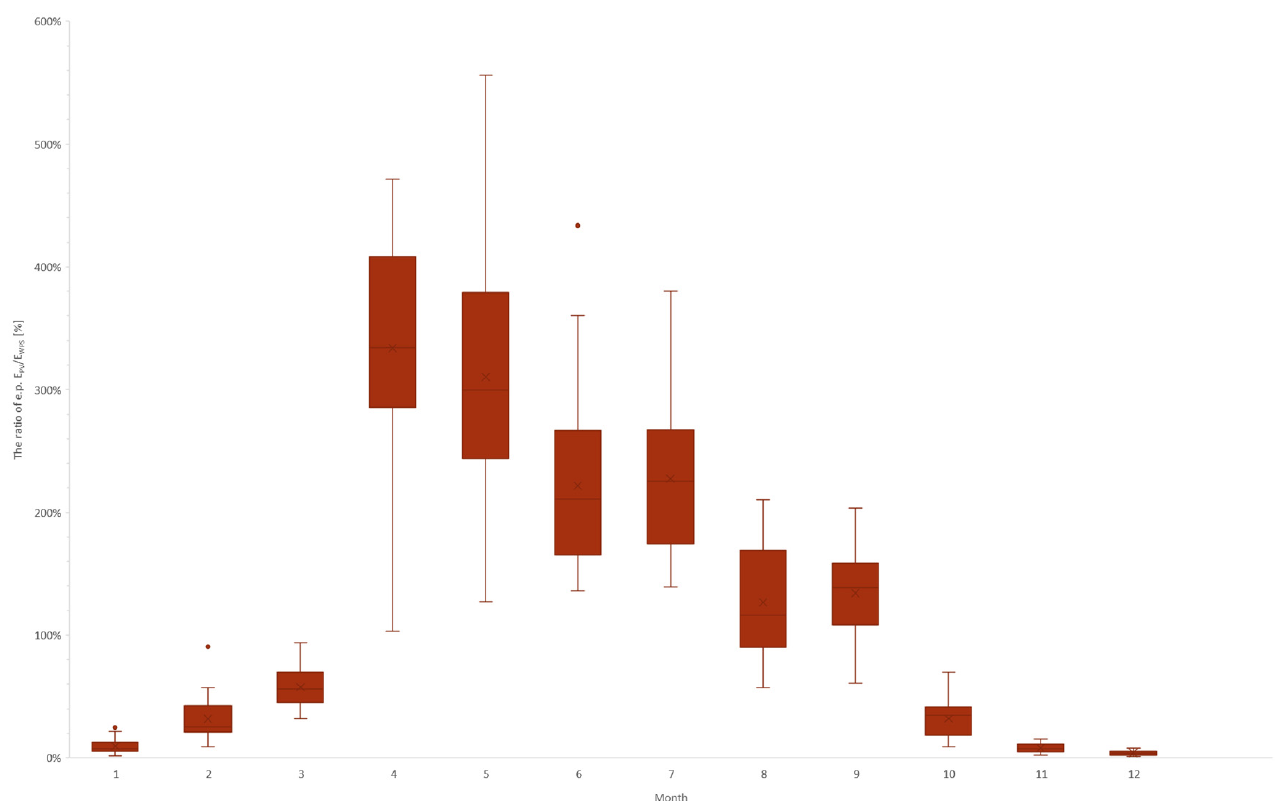
Figure 6. The ratio of electricity production (e.p.) from the PV installation (E PV ) to electricity consumption by the water-pumping station (E WPS ) (the dots - outliers and x - mean). In period II, the value of B varied between 57% and 210%. In June, for 75% of the days, the production of electricity from PV covered 100% of WPS’s demand. In August, for over 50% of the days, the production of electricity from PV covered 100% of WPS’s market. Q 3 was 159% in September and 169% in